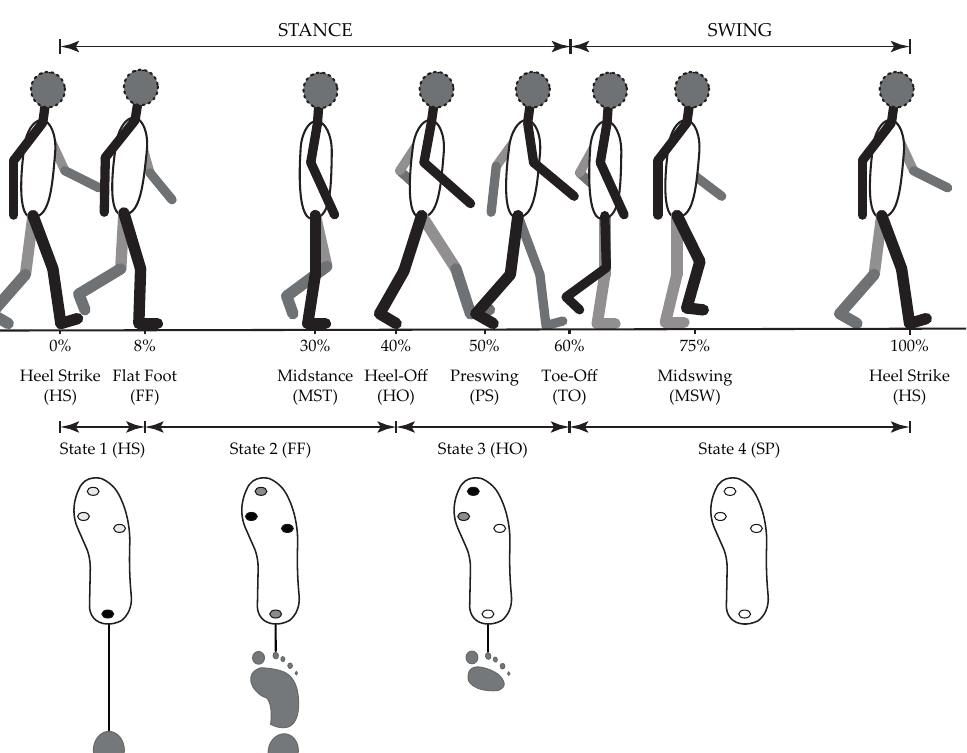
Figure 7. Gait phase detection based on FSR activation patterns. The gait cycle may be divided into seven phases, but four detected phases are sufficient for control purposes of an AFO. With this particular granularity, gait phases can be sequentially referenced from FSR data as follows: (i) HS State: Heel FSR is activated; (ii) FF State: first and fifth metatarsal FSR must be activated (black dots), and the activation of heel and toe FSRs is considered depending on specific study subject (grey dots); (iii) HO State: toe FSR must be activated, and the activation of first metatarsal FSR is considered depending on specific study subject; and (iv) SP State: all FSRs must be deactivated. Adapted from